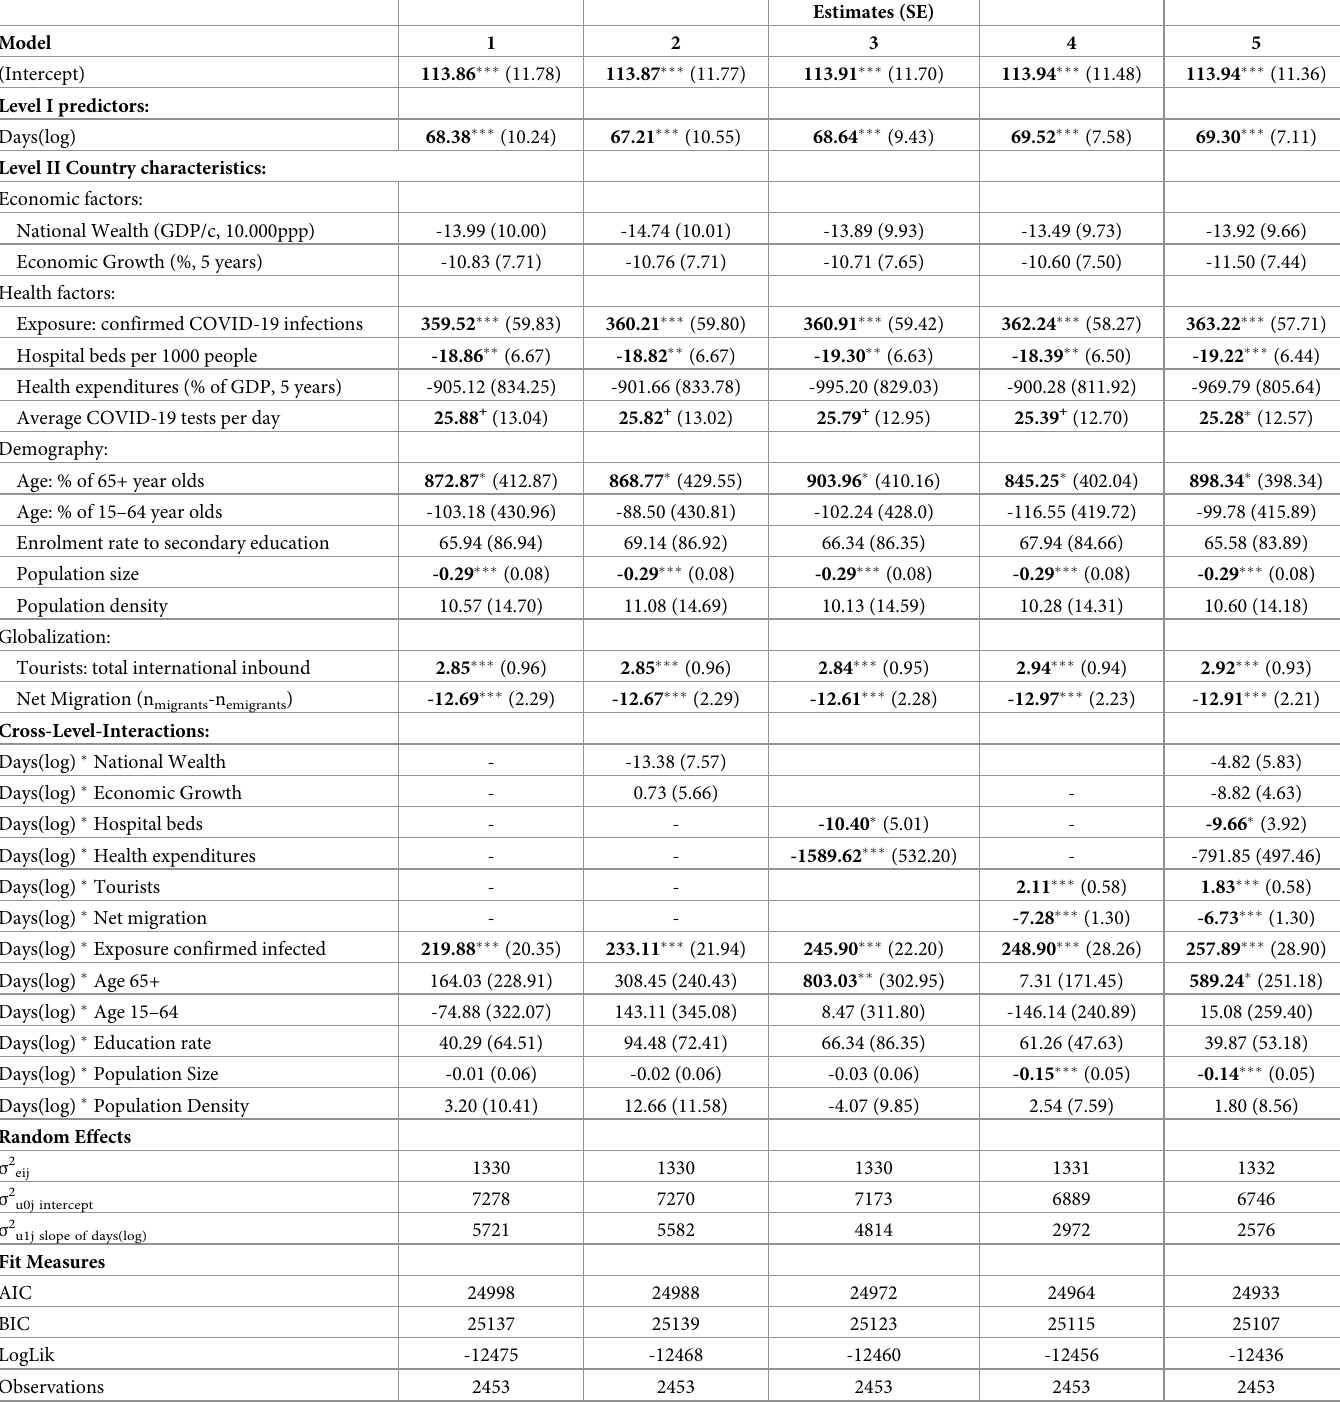
Table 1. Worldwide deaths by COVID-19: Multilevel analysis of longitudinal country-level data (31 st December 2019 to 2 nd April 2020).